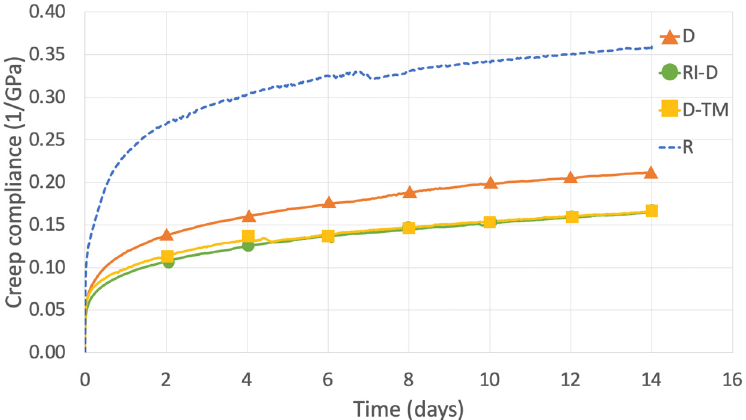
Figure 5. Average creep compliance of untreated and treated wood for 14 days. R is the reference group without any treatment; D is the densified group; RI-D is the resin-impregnated and densified group; D-TM is the densified and thereafter thermally modified group.